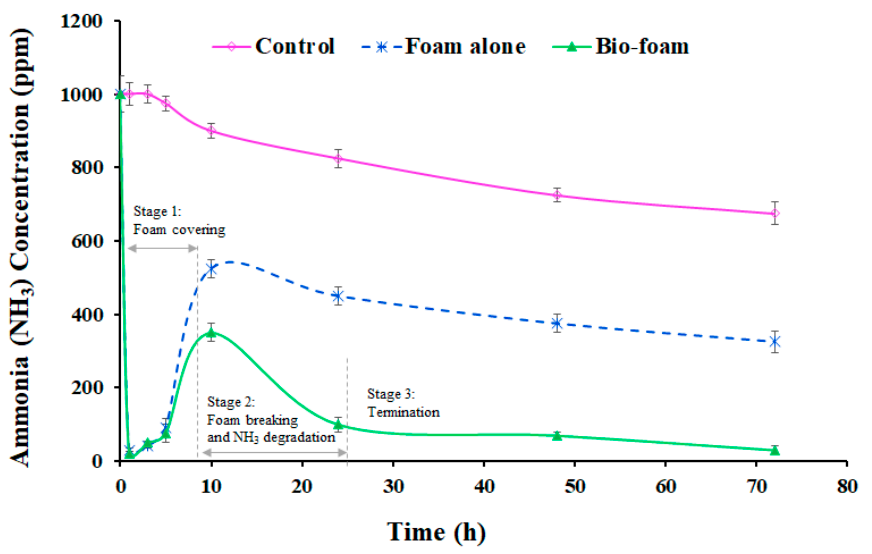
Figure 3. Change in NH3 concentration from NH 3 -contaminated soil with time in the closed reactor; control (no treatment), foam alone (application of surfactant foam only), and bio-foam (surfactant foam containing bacteria).